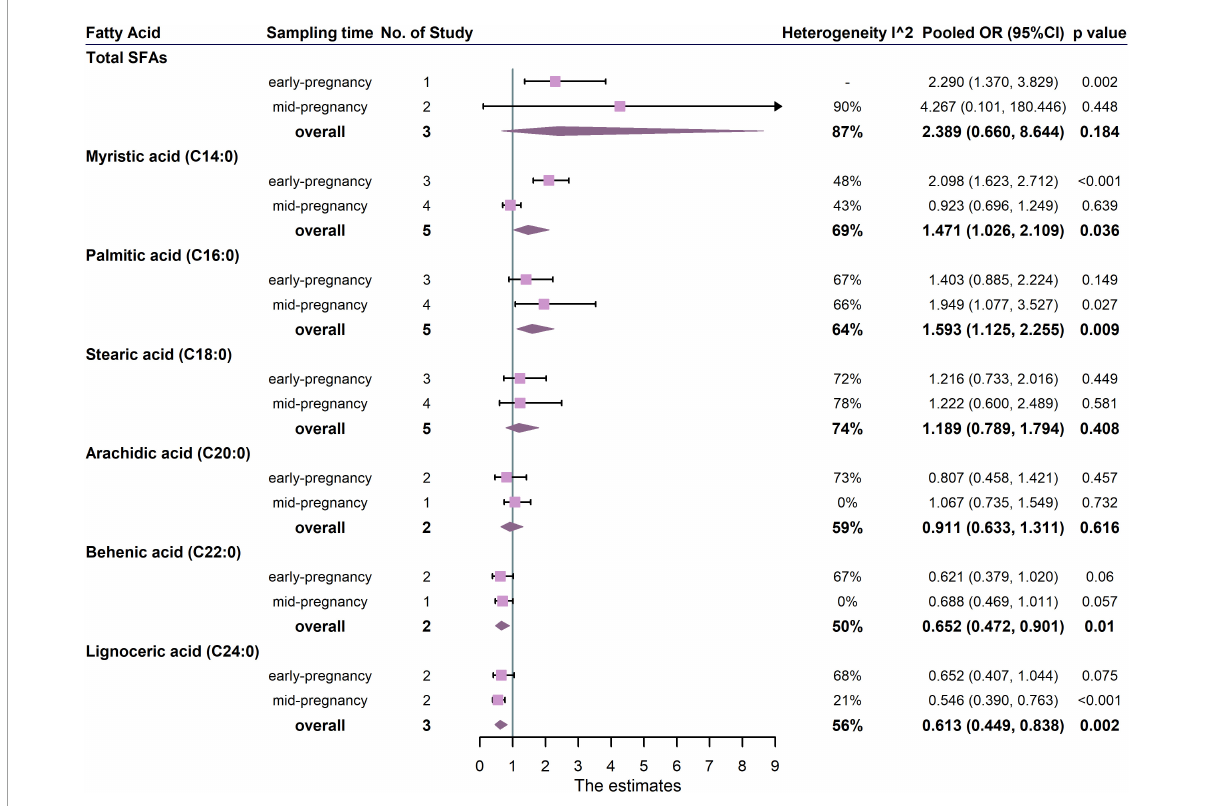
FIGURE5 Summary forest plot of pooled ORs of GDM for total SFAs and each SFA. Dots and horizontal lines represent ORs and 95% CIs. For each study, OR corresponds to the comparison of extreme quantiles of each saturated fatty acid. Diamonds depict pooled estimates from random-effects inverse-variance–weighted meta-analyses. Subgroup analysis was performed according to the sampling time of biological samples. The forest plots of the original studies were shown in the Supplementary Figure 4 .